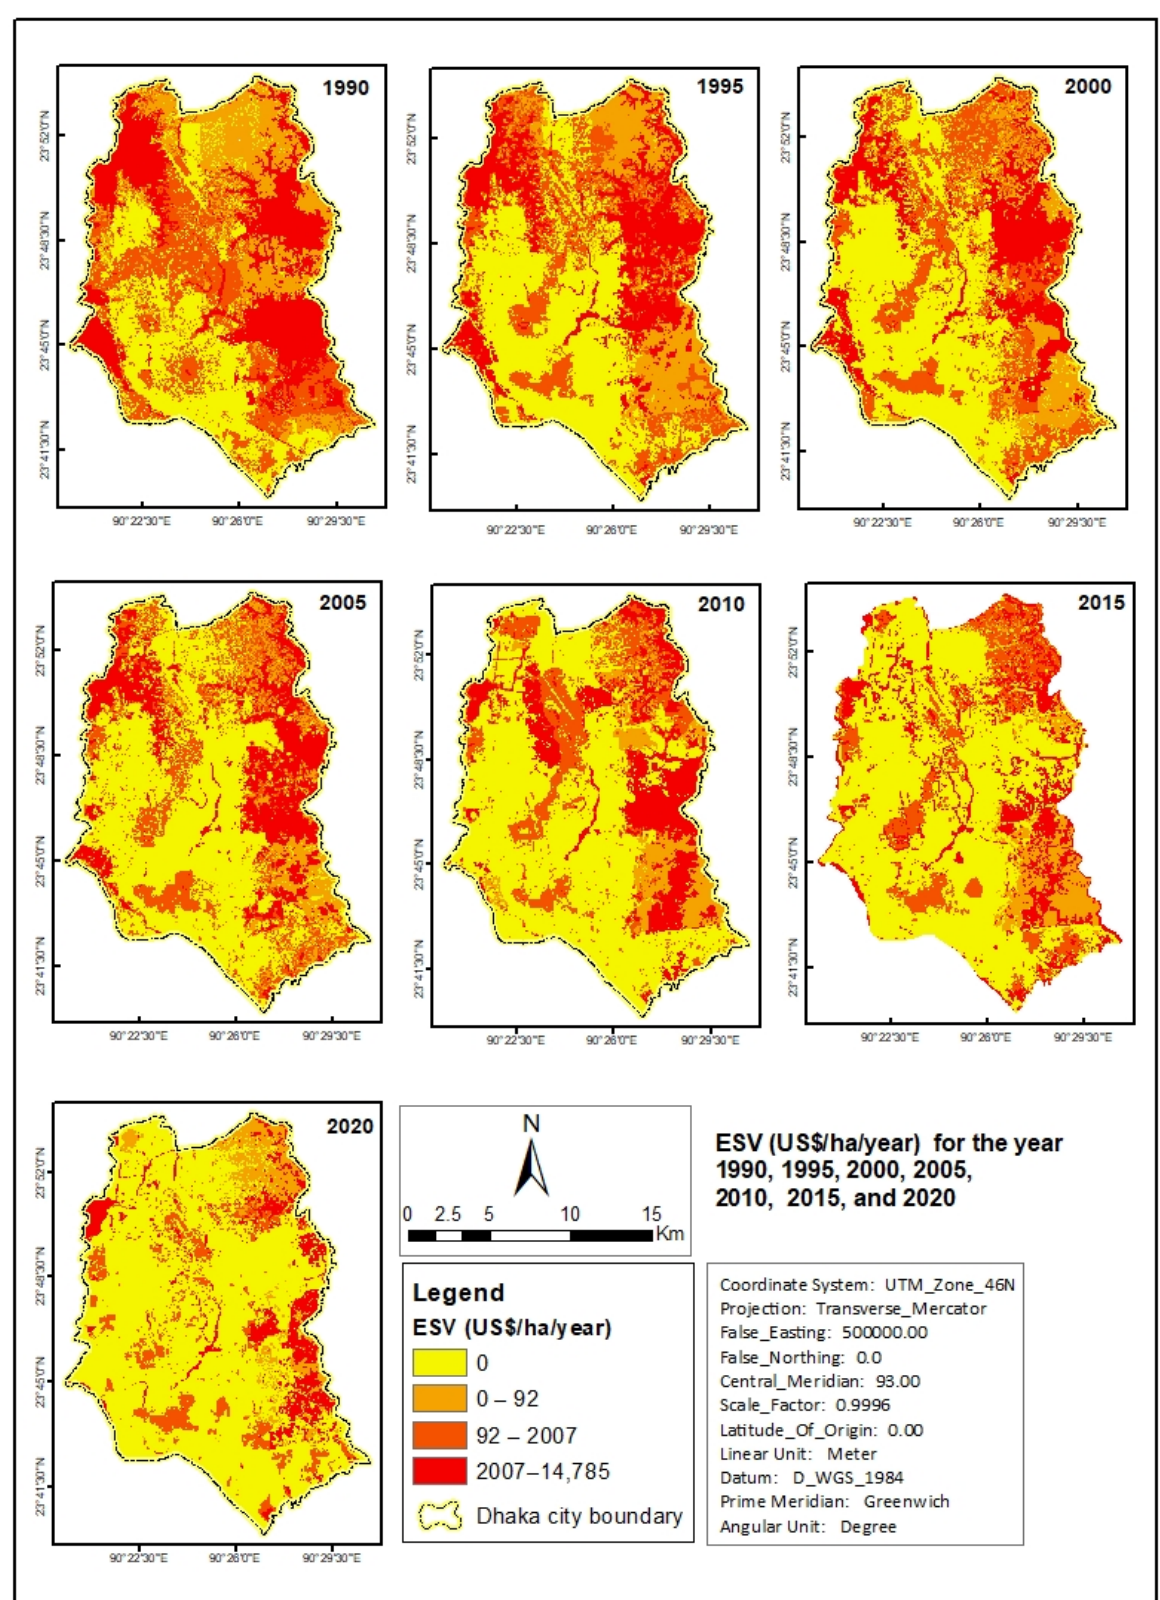
Figure 5. Spatial distribution of ESV (US$/ha/year) for the year 1990, 1995, 2000, 2005, 2010, 2015, and 2020.